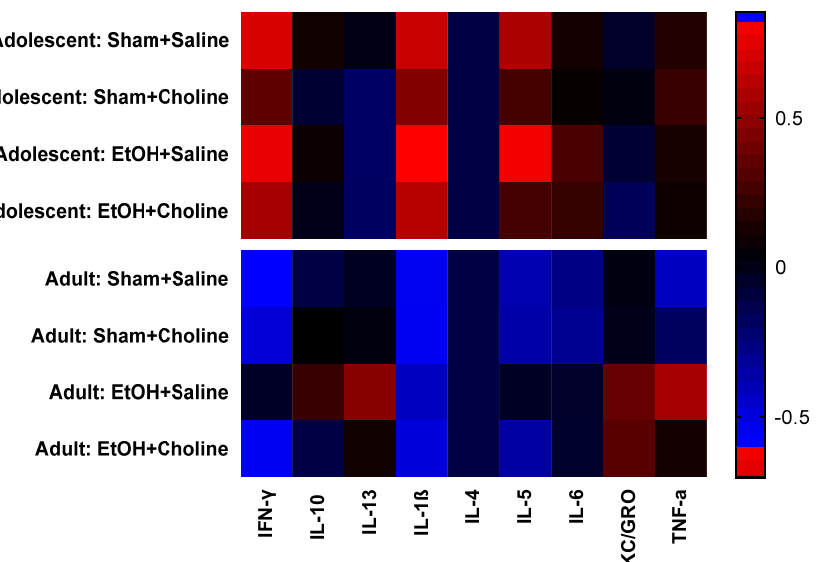
Figure 2. Hippocampal cytokine profiles during adolescence and adulthood. Overall, analysis demonstrates a noticeable clustering of cytokines patterns by age. Rows represent groups, as indicated, and the columns represent mean cytokine levels ( z -scored data) for each group. Colors demonstrate deviations from the mean of zero, as indicated in the color key. EtOH: Ethanol.